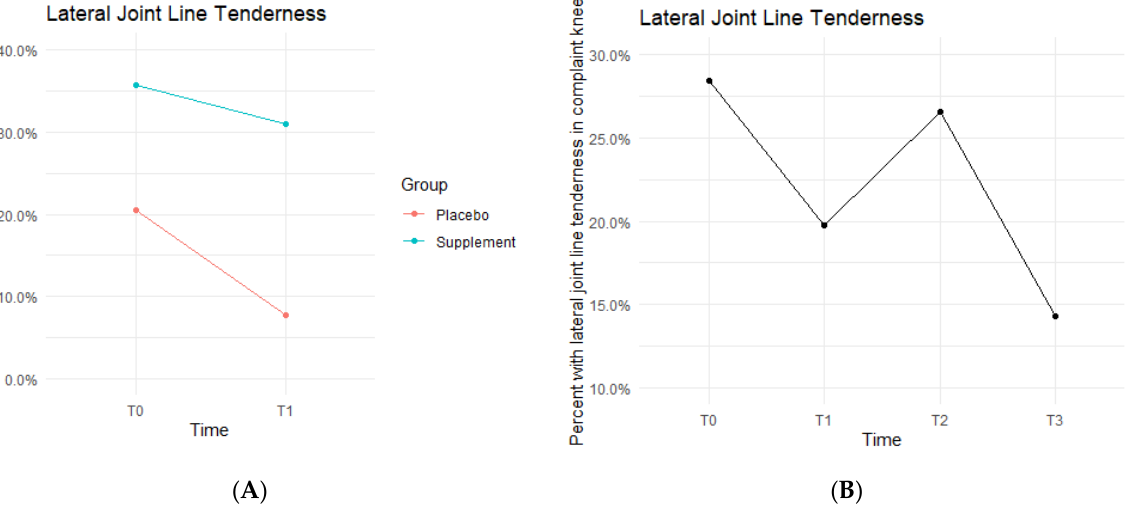
Figure 9. LJL Tenderness Changes Over Time. Average percentages of participants with LJL tenderness were graphed on a plot. ( A ) compares Supplement vs. Placebo from T0 to T1. ( B ) shows averages for the entire cohort as a whole at times T0, T1, T2, and T3. Only affected knees were included in the data.